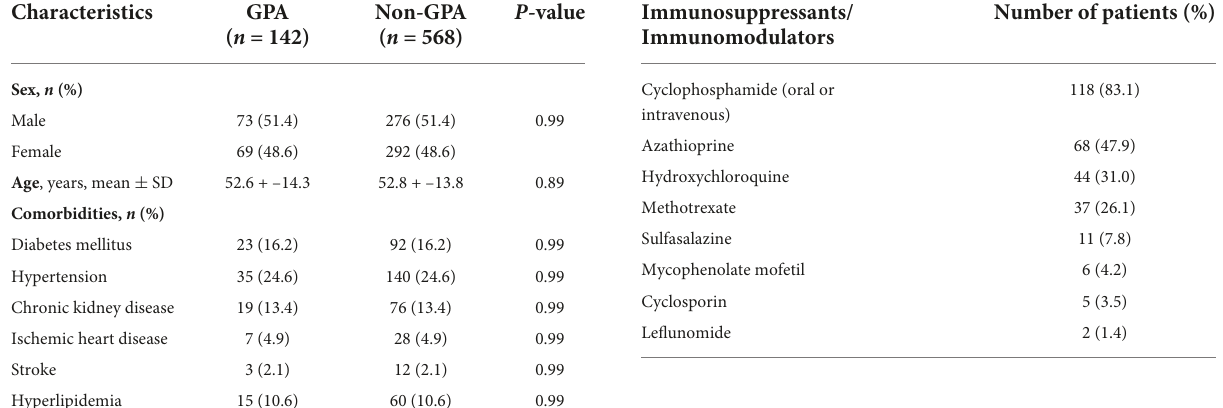
TABLE 2 Number and percentage of prescribed immunosuppressants among the 142 patients with granulomatosis with polyangiitis. Immunosuppressants/